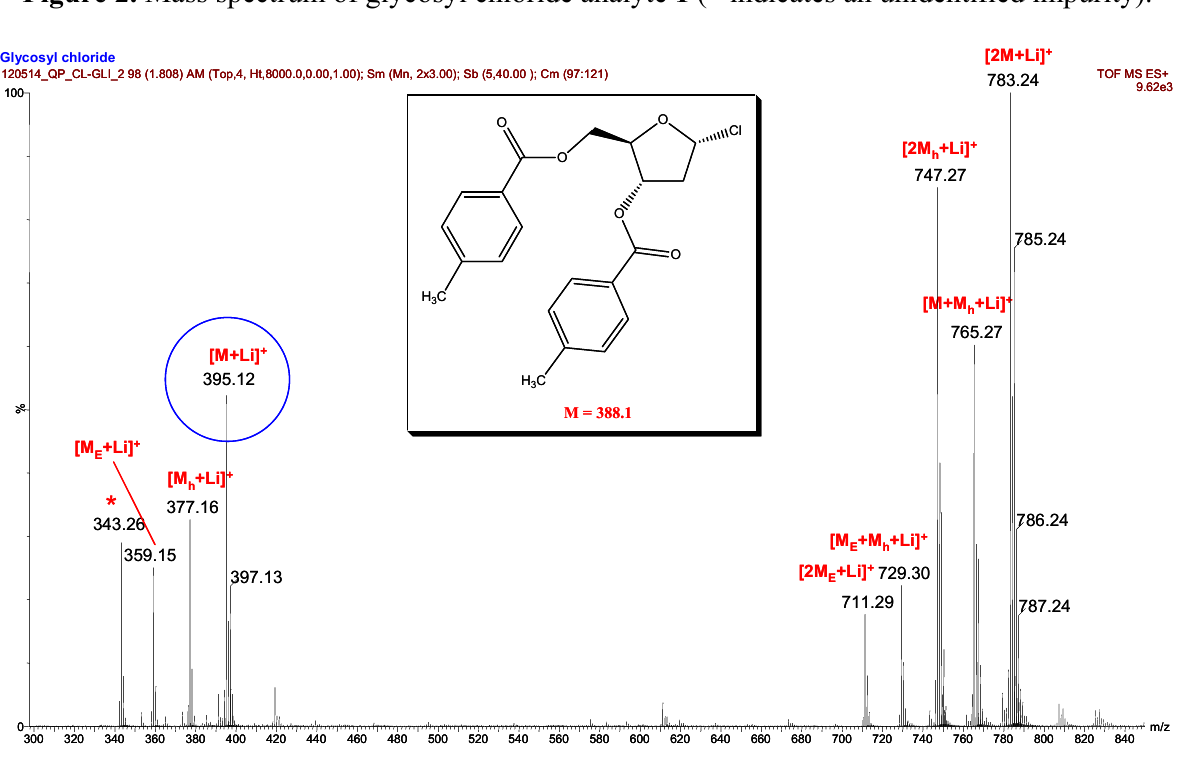
Figure 2. Mass spectrum of glycosyl chloride analyte 1 (* indicates an unidentified